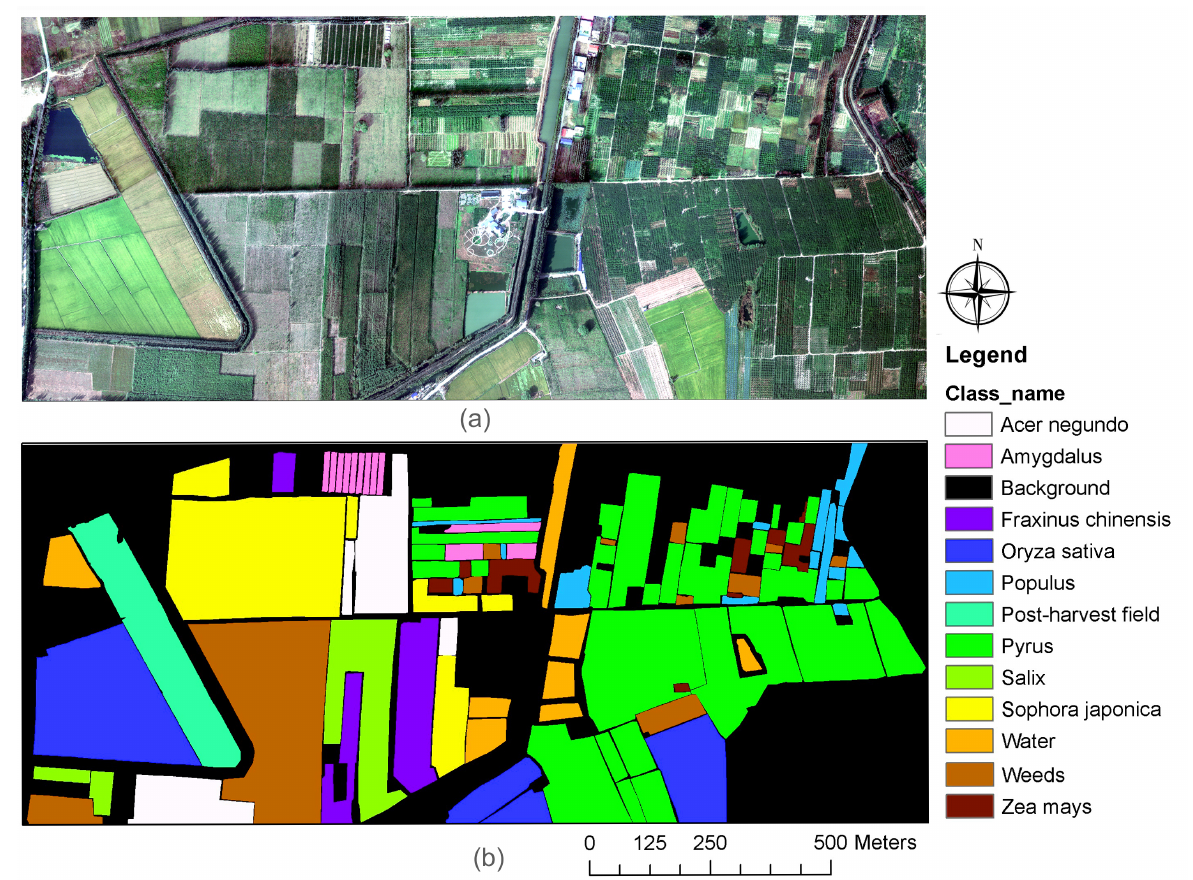
Figure 1. Hyperspectral remote sensing image and ground truth labels of Xiongan New Area. ( a ) RGB image and ( b ) ground truth